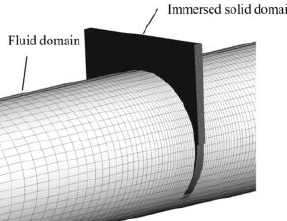
Figure 3. Overlapping of the fluid zone and immersed solid zone at time t =4 s (close to the end of the valve closure) in the immersed solid method for modelling valve movement.